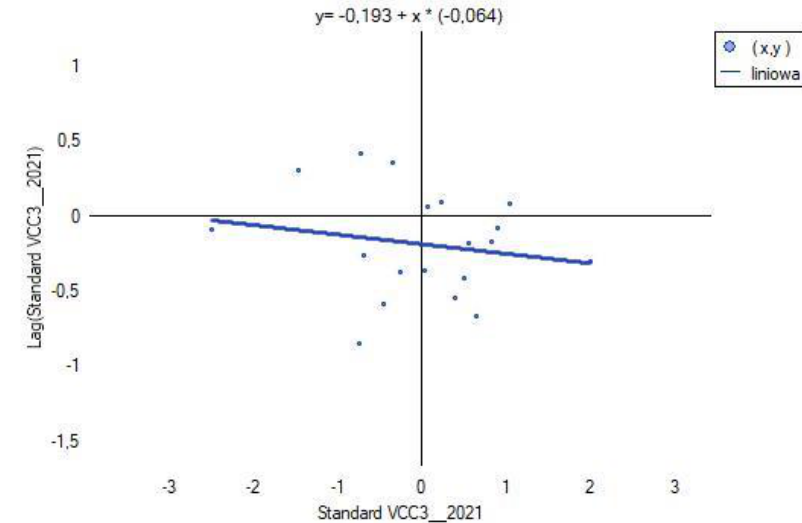
Figure 16. Chart of the global Moran’s index I for VCC2. Source: own study.